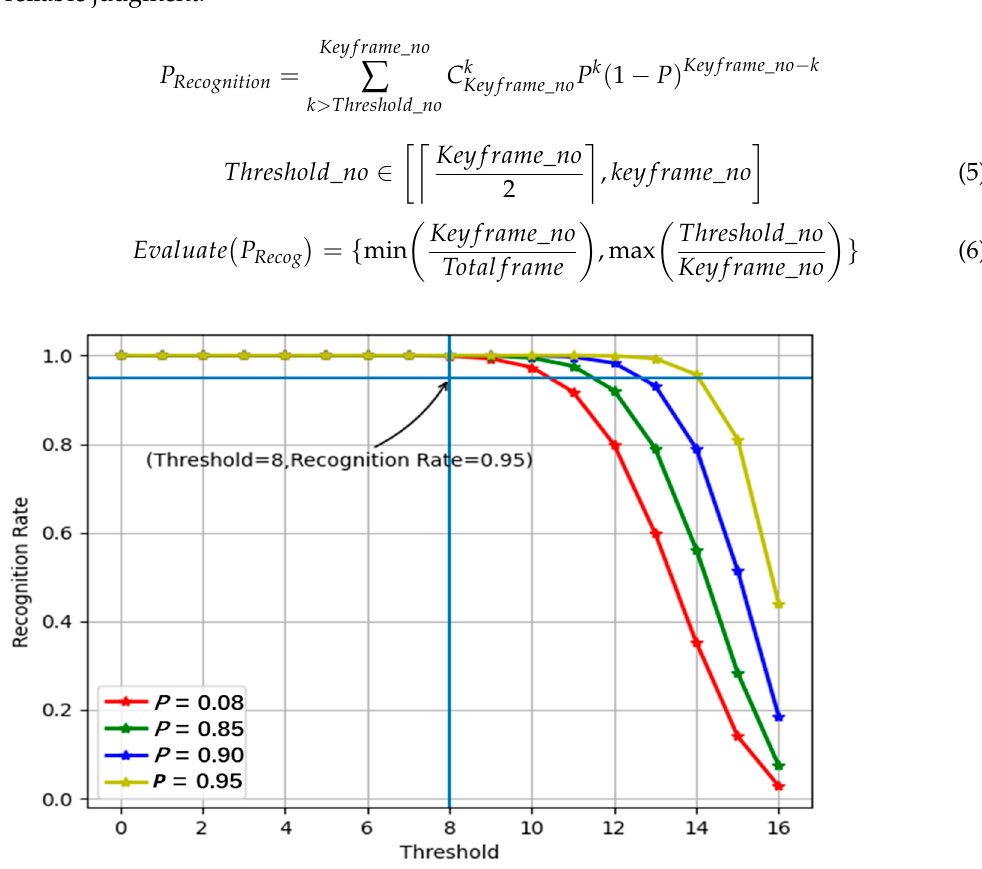
Figure 6. The relationship between Threshold and 𝑃 (cid:3019)(cid:3032)(cid:3030)(cid:3042)(cid:3034) .